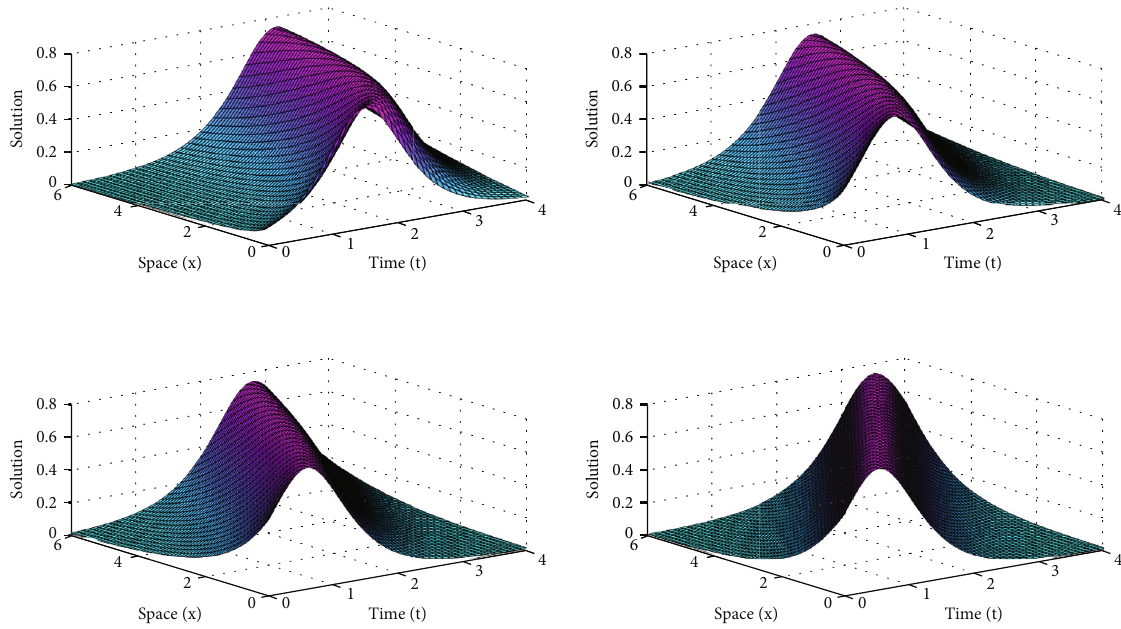
Figure 4: 3D diagram of Equation (45) with σ = 0 and various β